Question: Author a descriptive caption for the visualization shown.
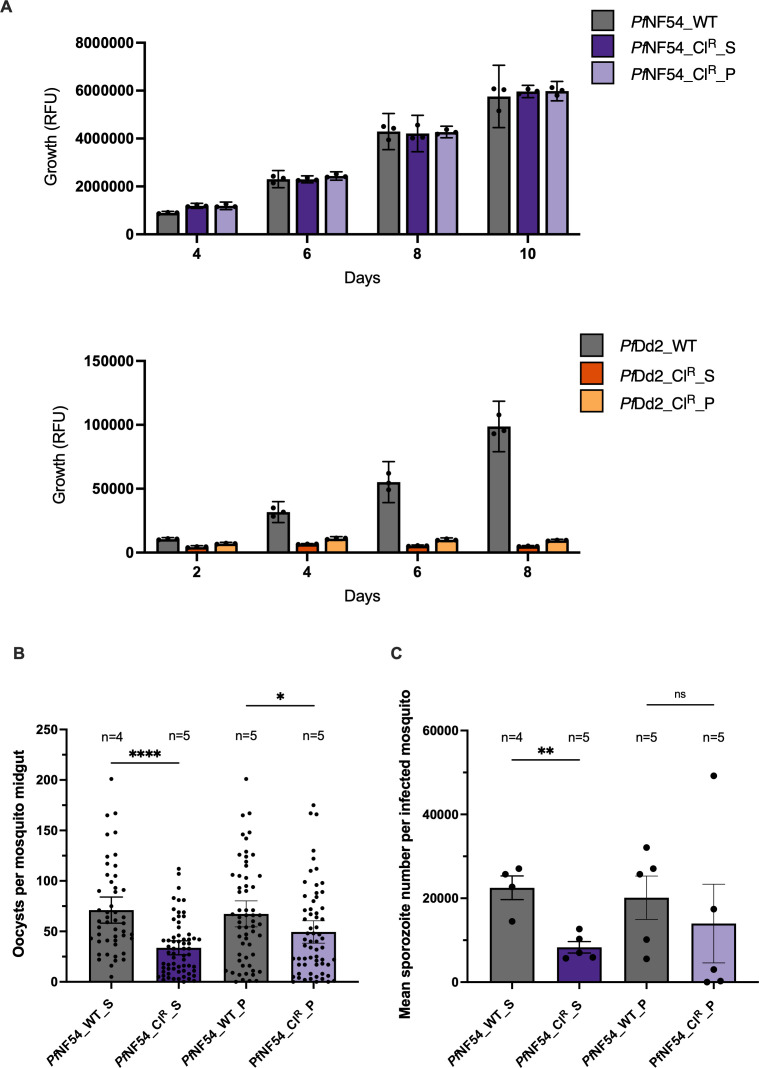
Answer: Asexual and sexual growth of NF54 and Dd2 clindamycin-resistant parasites. ( A ) Asexual growth of clindamycin-resistant NF54 and Dd2 parasite lines. Ring-stage parasites were plated in triplicate at a starting parasitemia of 0.5% and split 1:2 ( Pf NF54) or 1:4 ( Pf Dd2) every 48 h. Blood stage growth, measured by relative fluorescence units (RFU), of clindamycin-resistant parasites was determined relative to the wild-type control across four cycles using a SYBR Green I-based fluorescence assay. Error bars represent the mean ± 95% confidence interval. ( B ) Pf NF54_Cl R _S and Pf NF54_Cl R _P are impacted in the development of mosquito midgut oocysts. Control infections for Pf NF54_Cl R _S and Pf NF54_Cl R _P are shown as Pf NF54_WT_S and Pf NF54_WT_P, respectively. A minimum of 10 midguts from A. stephensi mosquitoes infected with Pf NF54_WT_S, Pf NF54_Cl R _S, Pf NF54_WT_P, and Pf NF54_Cl R _P or Pf NF54_Cl R _P were dissected per independent infection (“ n ”) at either day 7 or 8 post-mosquito blood feed for oocyst counts. Statistical significance was determined using the Mann-Whitney non-parametric test (**** P ≤ 0.0001, * P ≤ 0.05), and error bars represent the median ± 95% confidence interval. ( C ) Pf NF54_Cl R _S, but not Pf NF54_Cl R _P, produced significantly fewer salivary gland sporozoites compared to control parasites. Pf NF54_WT_S and Pf NF54_WT_P represent control infections for Pf NF54_Cl R _S and Pf NF54_Cl R _P, respectively. The mean sporozoite number per independent experiment (“ n ”) was obtained by dissecting salivary glands of at least 10 infected mosquitoes. Statistical significance was determined using paired t -test (** P ≤ 0.01), error bars represent the mean ± SEM.